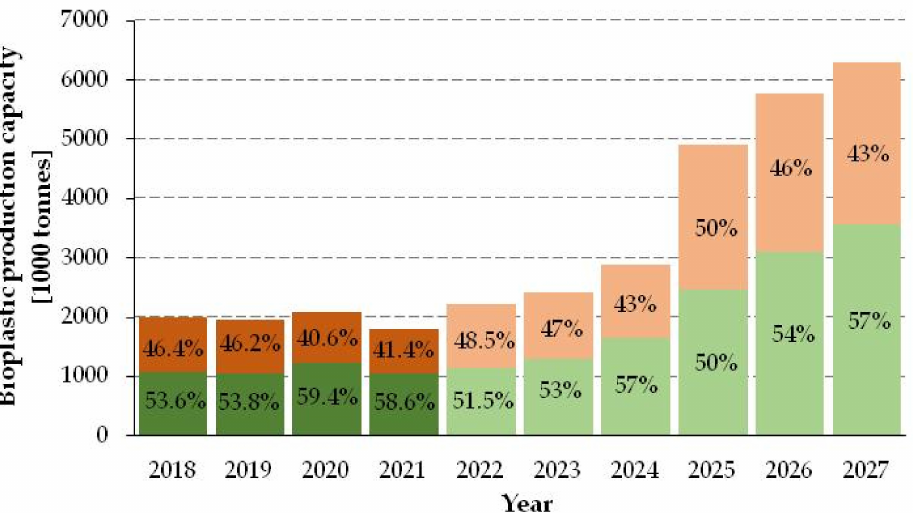
Figure 1. Global production capacities of bioplastics. Biodegradable bioplastics (green columns) and bio-based, non-biodegradable plastics (brown columns). Dark and pale colors indicate actual and forecasted data, respectively. Different numbers in the columns indicate percentage ratios between the two categories. Data reported by the European Bioplastics Association